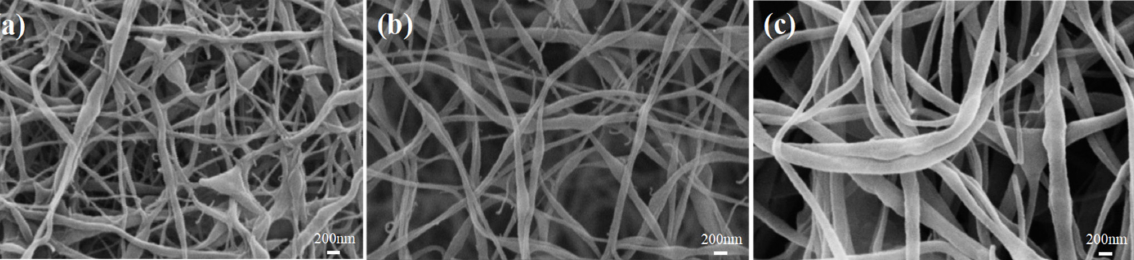
Figure 5. SEM images of PVDF/SDS nanofiber membrane with different PVDF concentrations: ( a ) 8 wt%, ( b ) 10 wt%, and ( c ) 12